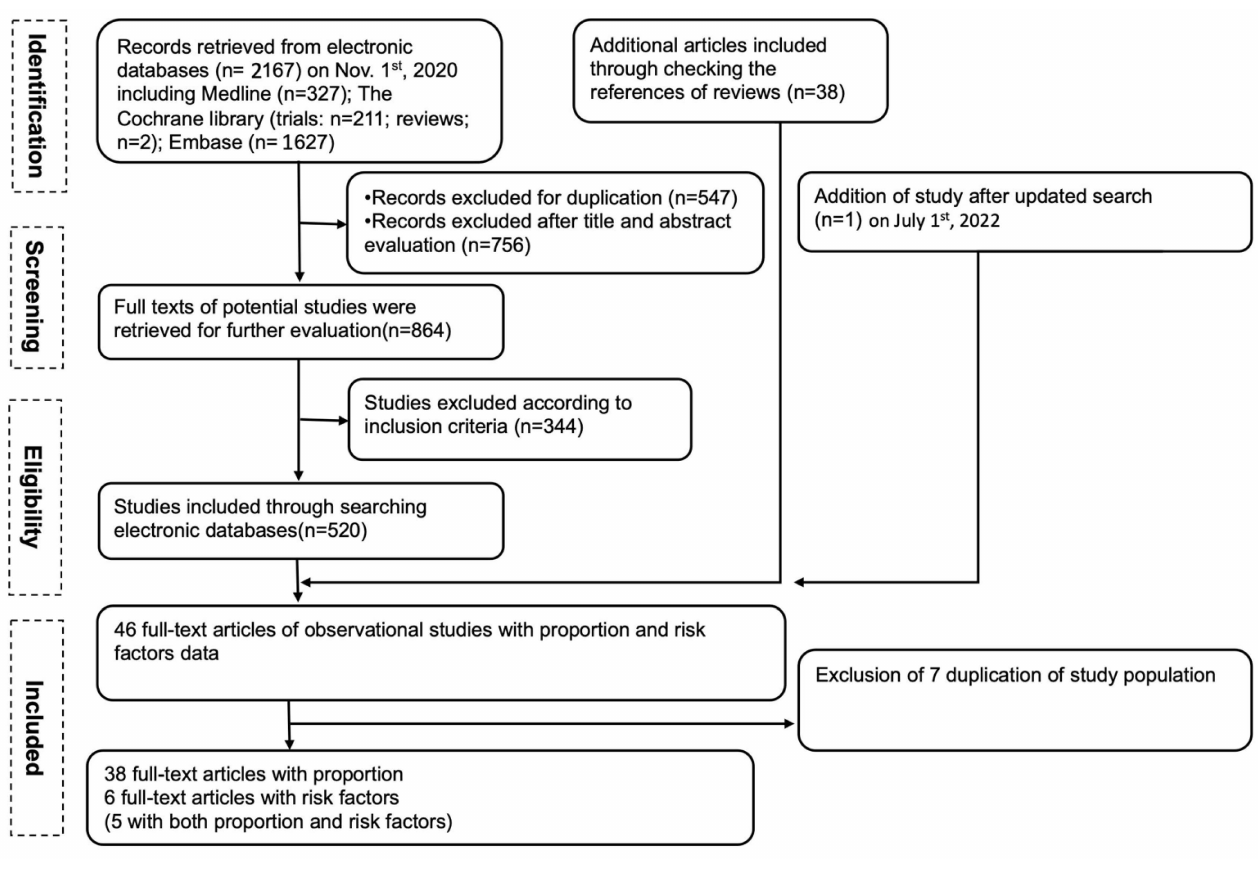
Figure 1. The study flow chart. Table 1. Proportion of MBM by melanoma type and timing of MBM (i.e., at diagnosis (Dx) or after